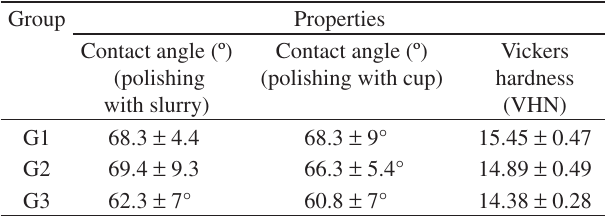
Table 2. Mean results and standard deviation of Contact Angles (º) and Vickers hardness (VHN) of the materials studied. Group